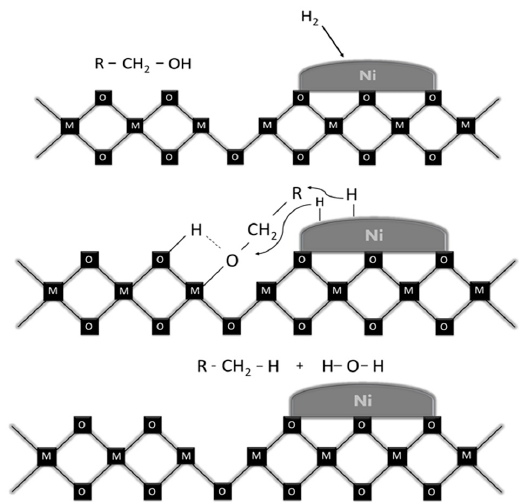
Figure 9. Simplified representation of hydrodeoxygenation over Ni-based catalysts: R–CH 2 –OH represents the molecules to be hydrodeoxygenated, and M-O represents the support material (SiO 2 and SiO 2 -ZrO 2 -Al 2 O 3 ), NiO, and Cr 2 O 3 . NiO is reduced during the hydrotreatment reaction. The particle sizes of Cr 2 O 3 are smaller compared to metallic nickel (not represented in the Figure), but the mechanism of hydrodeoxygenation is assumed to be the same as the support material.